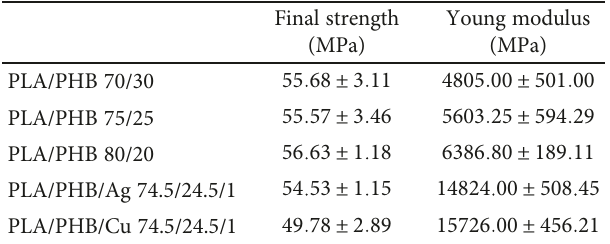
Table 6: Final strength (MOR) and Young modulus (MOE) values for